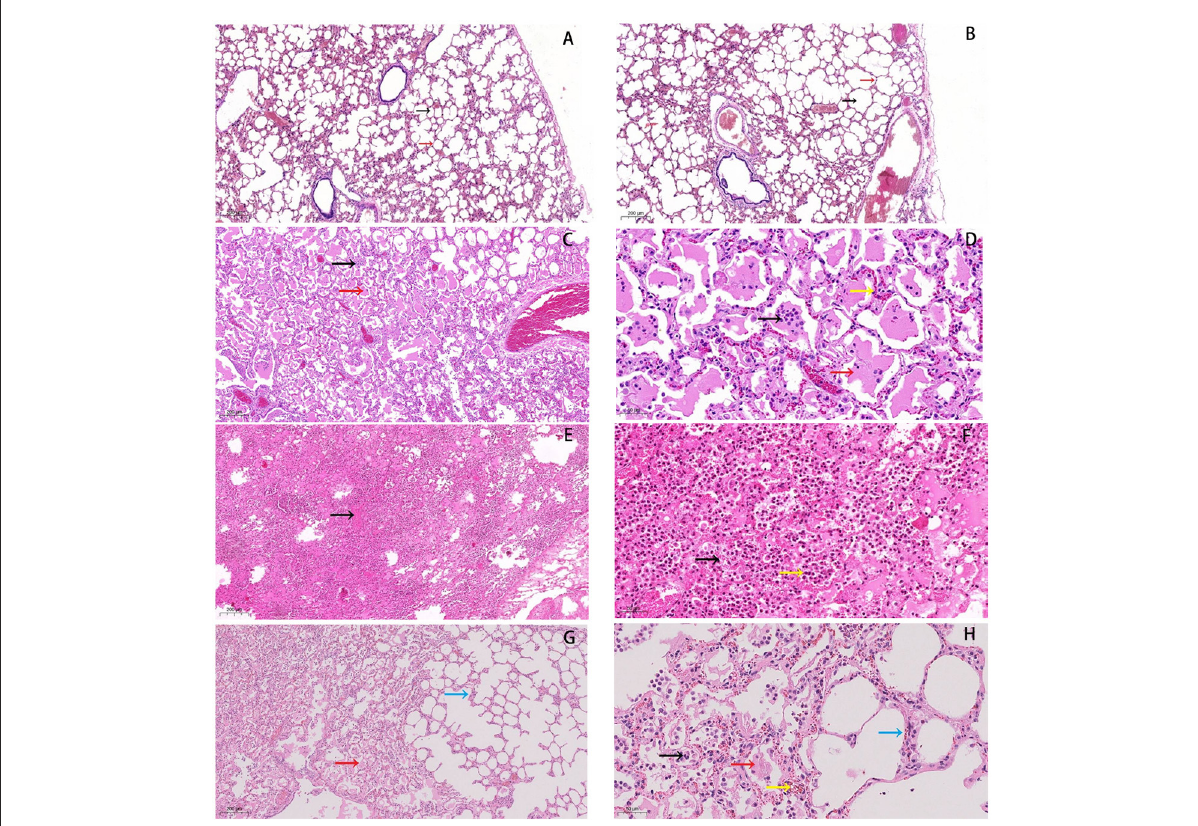
FIGURE1 Histopathological changes in lungs of forest musk deer. (A,B) normal lung tissue in the control group, HE staining of normal tissues was performed (5 × ). The black arrow indicates the alveolar cavity, the red arrow points to the alveolar wall. (C,D) Inflammatory cells (black arrow) and exudate can be seen in the alveolar cavity (red arrow), and the capillaries in the alveolar wall are hyperemic (yellow arrow). (E,F) Numerous broken neutrophils (yellow arrow) exuded from the alveolar cavity, bleeding obvious (black arrow). (G,H) Red blood cell (yellow arrow), inflammatory cell (black arrow) and fibrin exudates (red arrow) present in alveolar lumen, and lung interstitium is widened (blue arrow). Bars: (B,D,F,H) 50 µ m, Bars: (A,C,E,G) 200 µ m, (magnification, 5.0 × , 20.0 ×